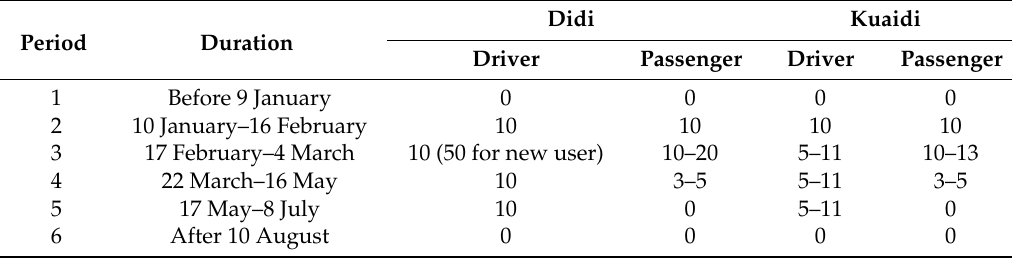
Table 1. The division of the subsidy war (Unit: RMB Yuan). Didi Kuaidi